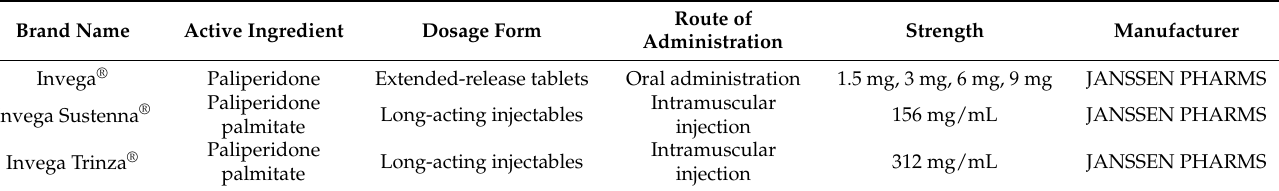
Table 1. PPD formulations approved by the U.S. FDA.